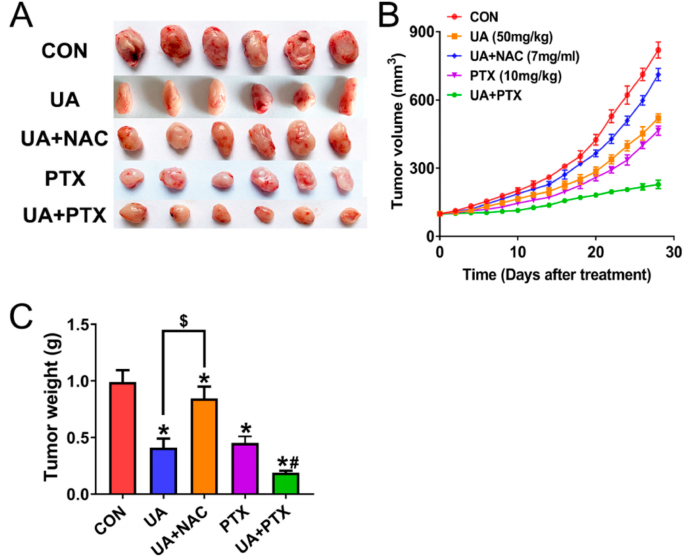
Figure 8. ( + )-Usnic acid (UA) inhibits H520 xenograft tumor growth and enhances paclitaxel e ffi cacy in vivo. ( A – C ) UA (50 mg / kg, thrice weekly, by intraperitoneal injection), UA plus the NAC (7 mg / mL given in the drinking water for the length of the experiment), PTX (10 mg / kg, thrice weekly, by intraperitoneal injection), or UA plus the PTX treatment inhibit tumor volume ( A,B ) and tumor weight ( C ). * Significantly di ff erent from control group; # significantly di ff erent from the group of UA or PTX; $ significantly di ff erent between the group of UA and UA plus NAC, p < 0.05, n =